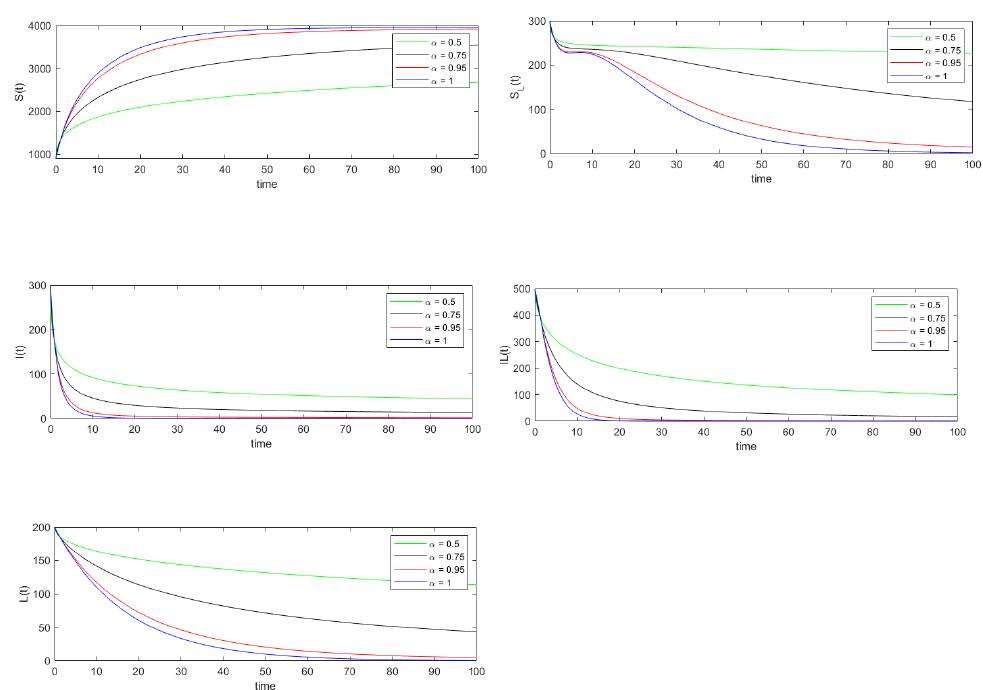
Figure 2. Approximated solution of system (8) using the residual power series method when R 0 < 1. Note that the values of the parameters used in this figure are the same as the one in Figure